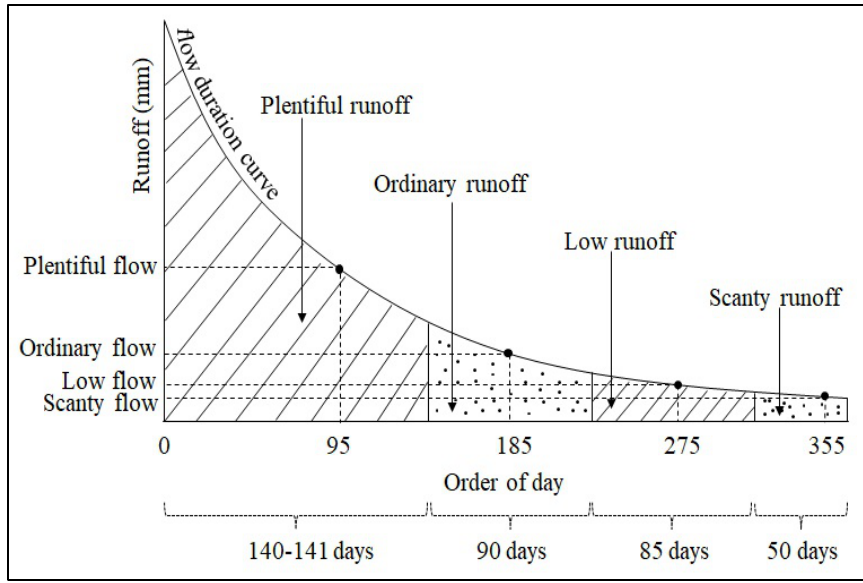
Figure 2. Flow–duration curve, modified from Nakano et al. [39].